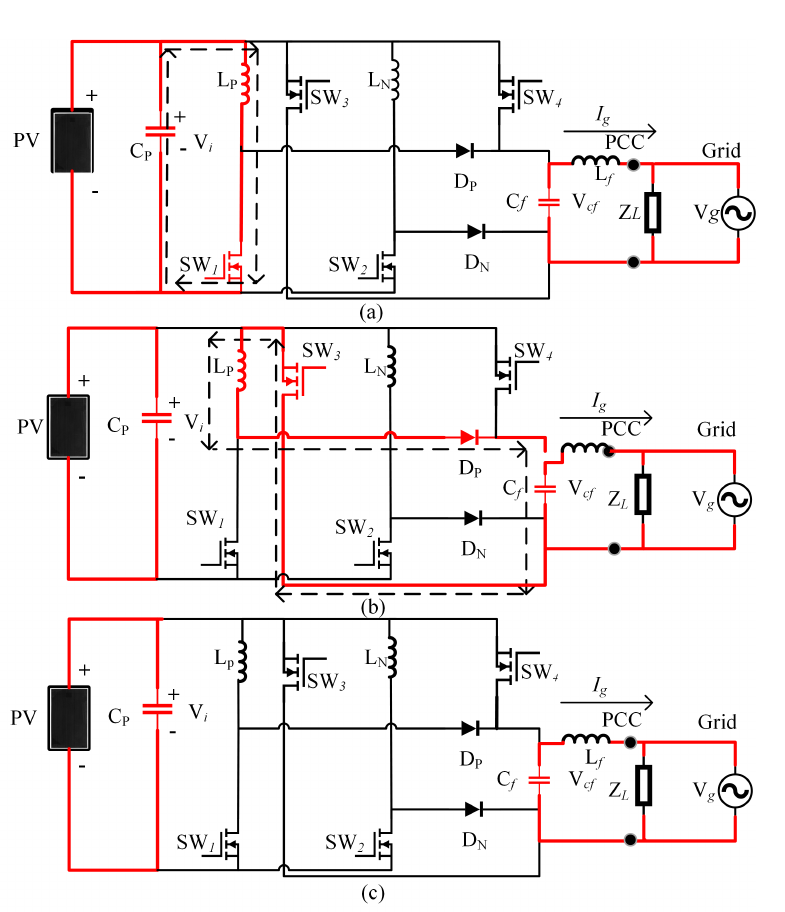
Figure 2. ( a ) Circuits that are equivalent to Mode P 1 . ( b ) Circuits that are equivalent to Mode P 1 . ( c ) Circuits that are equivalent to Mode P 1